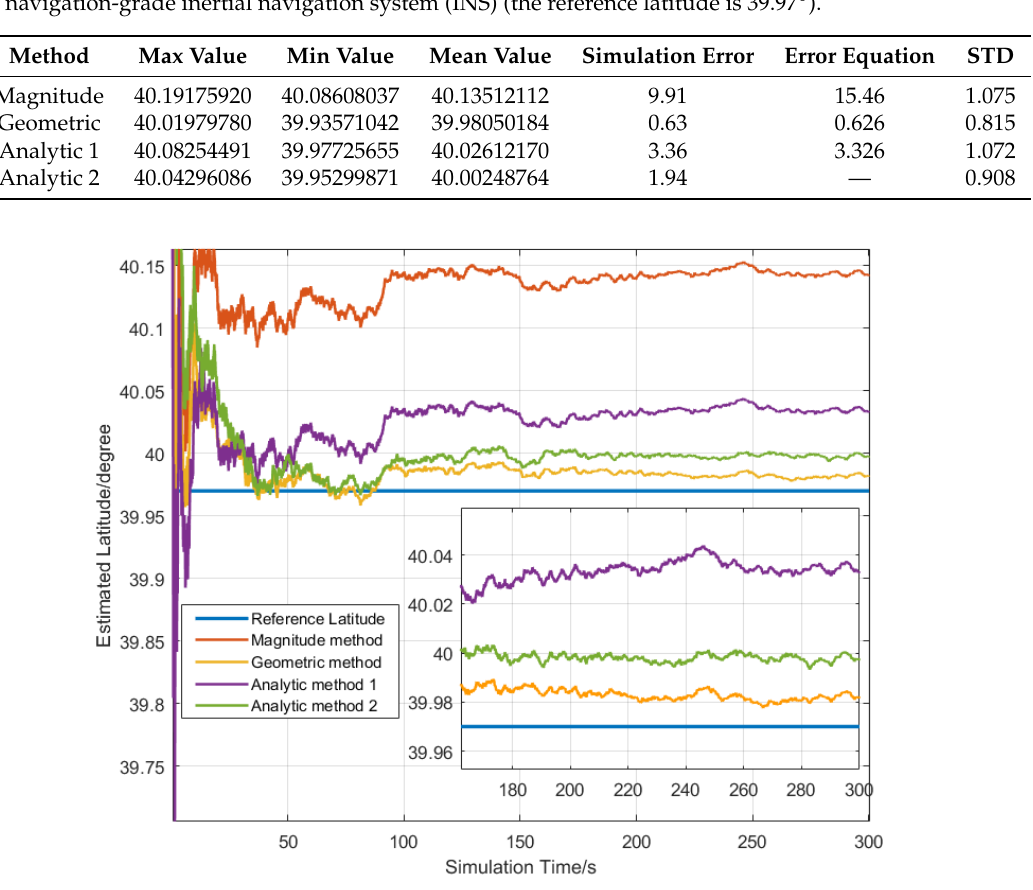
Figure 2. Latitude estimation convergence curve for LD